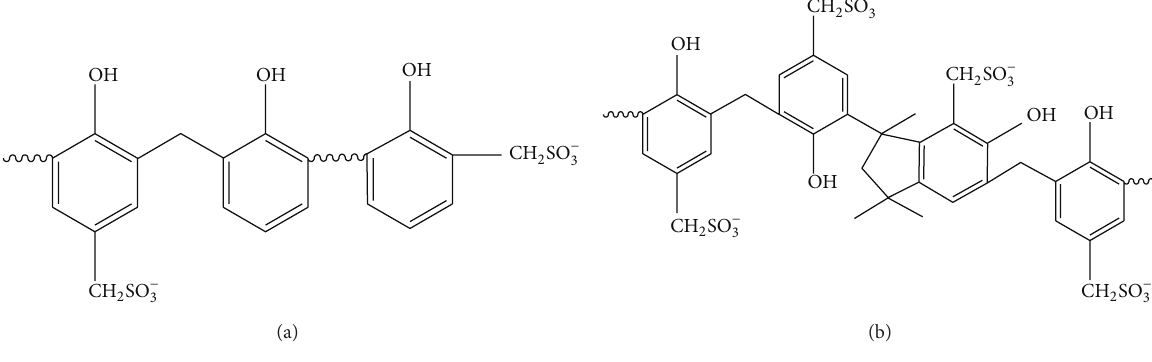
Figure 7: Structural representation of PF and